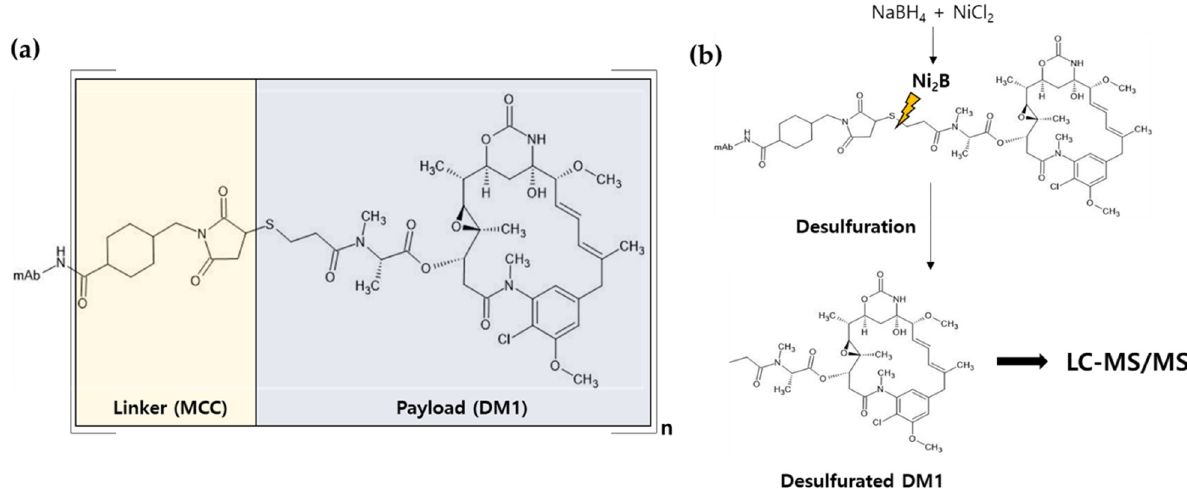
Figure 1. ( a ) Chemical structure of T-DM1 and ( b ) desulfuration reaction in the thioether bond between MCC linker and DM1 of T-DM1 by sodium borohydride (NaBH 4 ) and nickel chloride hexahydrate (NiCl 2 · 6H 2 O) chemical reagents.